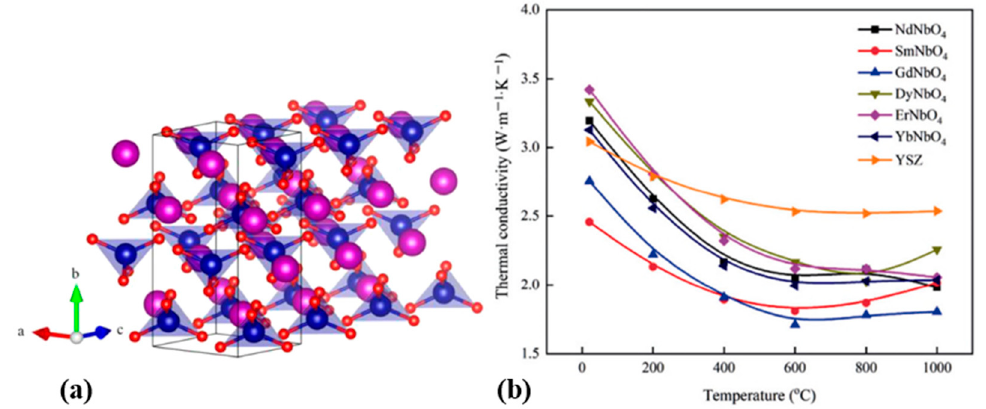
Figure 38. ( a ) Crystal structure ( b ) thermal conductivity of RENbO 4 ceramic [196].